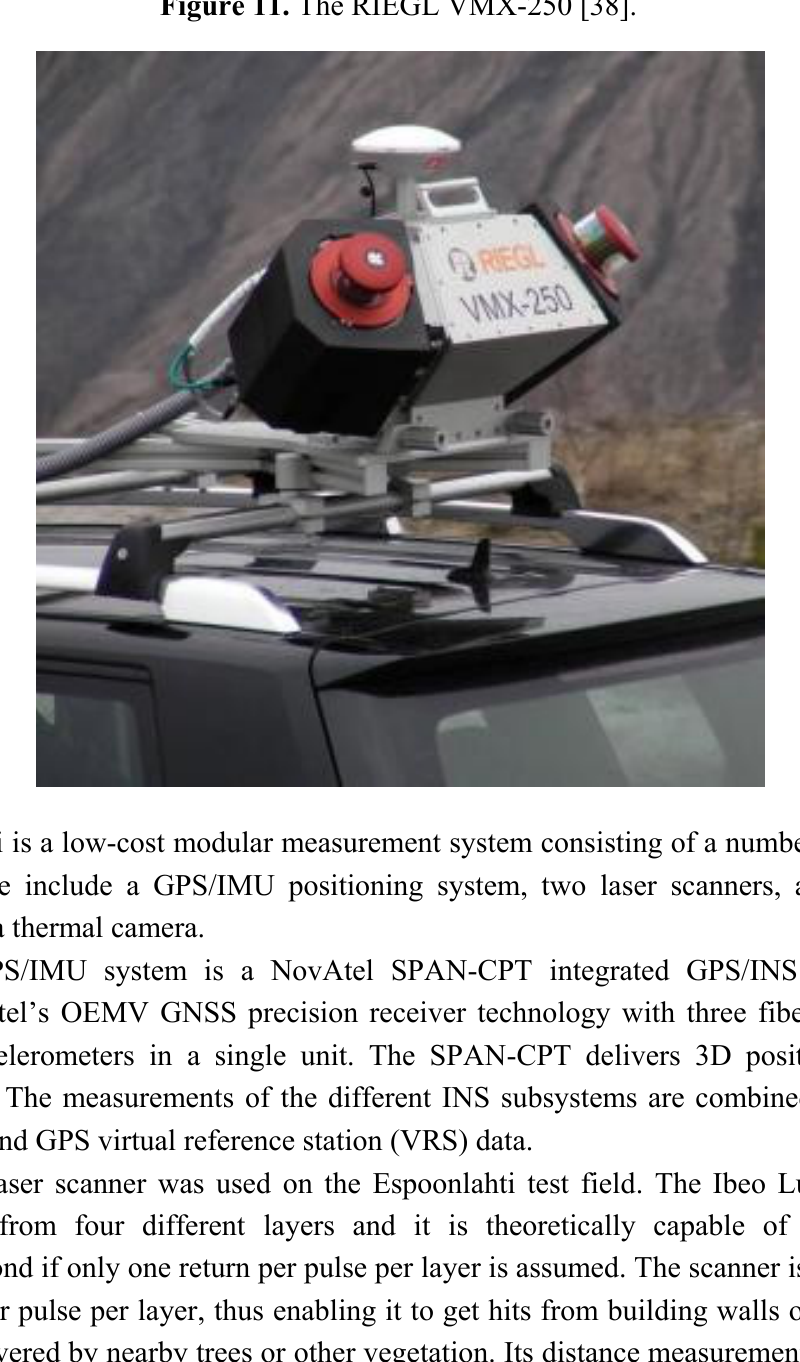
Figure 11. The RIEGL VMX-250